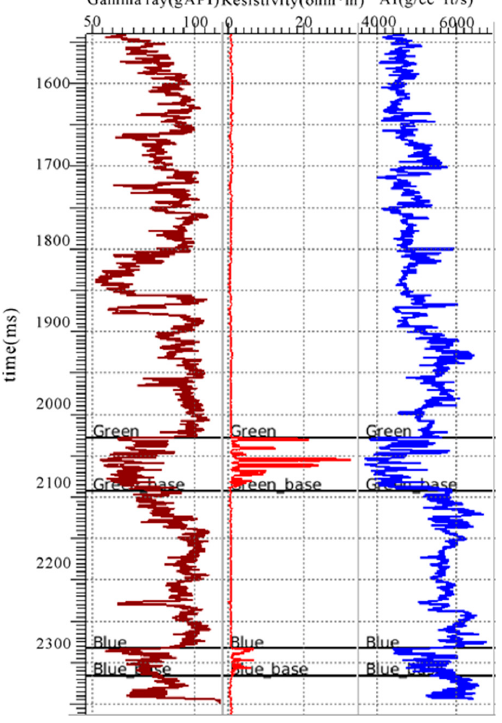
Figure 7. Gamma-ray, resistivity and impedance curve in Well 4.